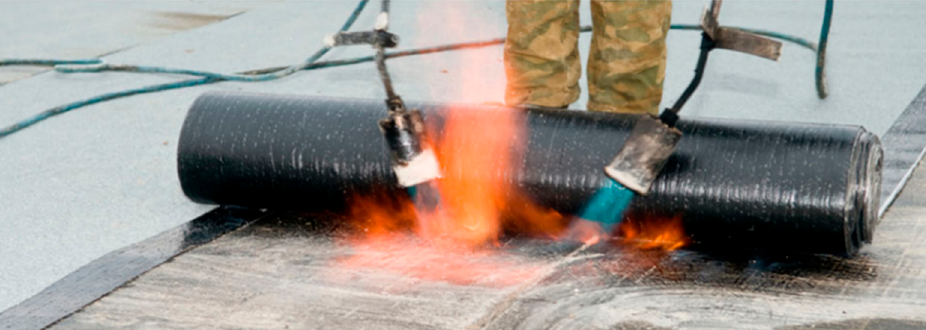
Figure 2. Application of a torch-on membrane—heating up the material with gas torches.